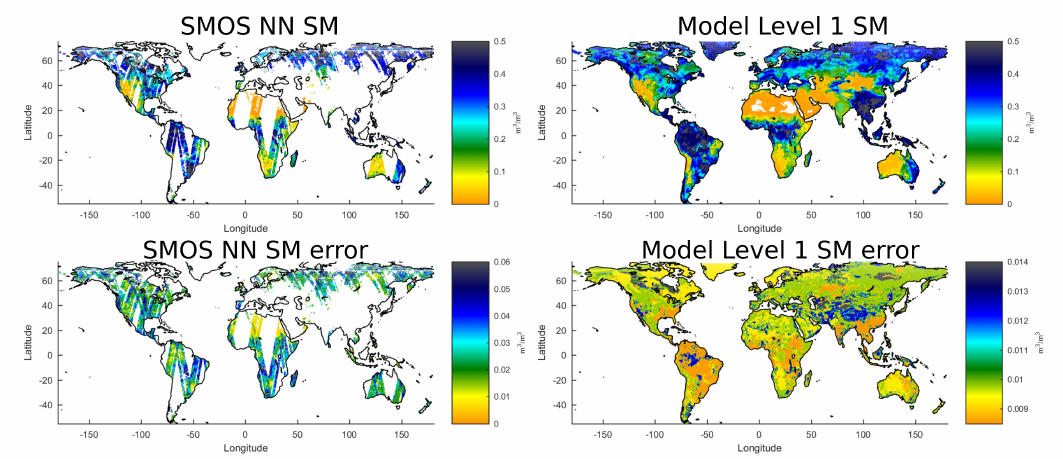
Figure 2. ( Upper left ): SMOS NNSM for day 4 June 2012. ( Lower left ): SMOS NNSM observation error. ( Upper right ): model background for the same day and first layer (ECMWF SM 1 ). ( Lower right ): Model background error (5% of the water holding capacity). Units are m 3 /m 3 .